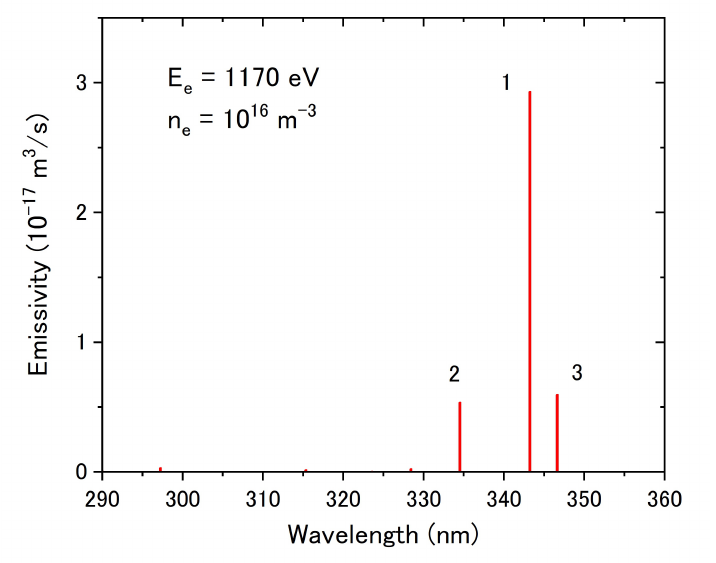
Figure 4. Emission line spectrum of the CR model for W 29 + . The transition of the line 1 is ) [( 4 d − 2 4 4 f 7/2 5/2 and the line 3 [( 4 d − 2